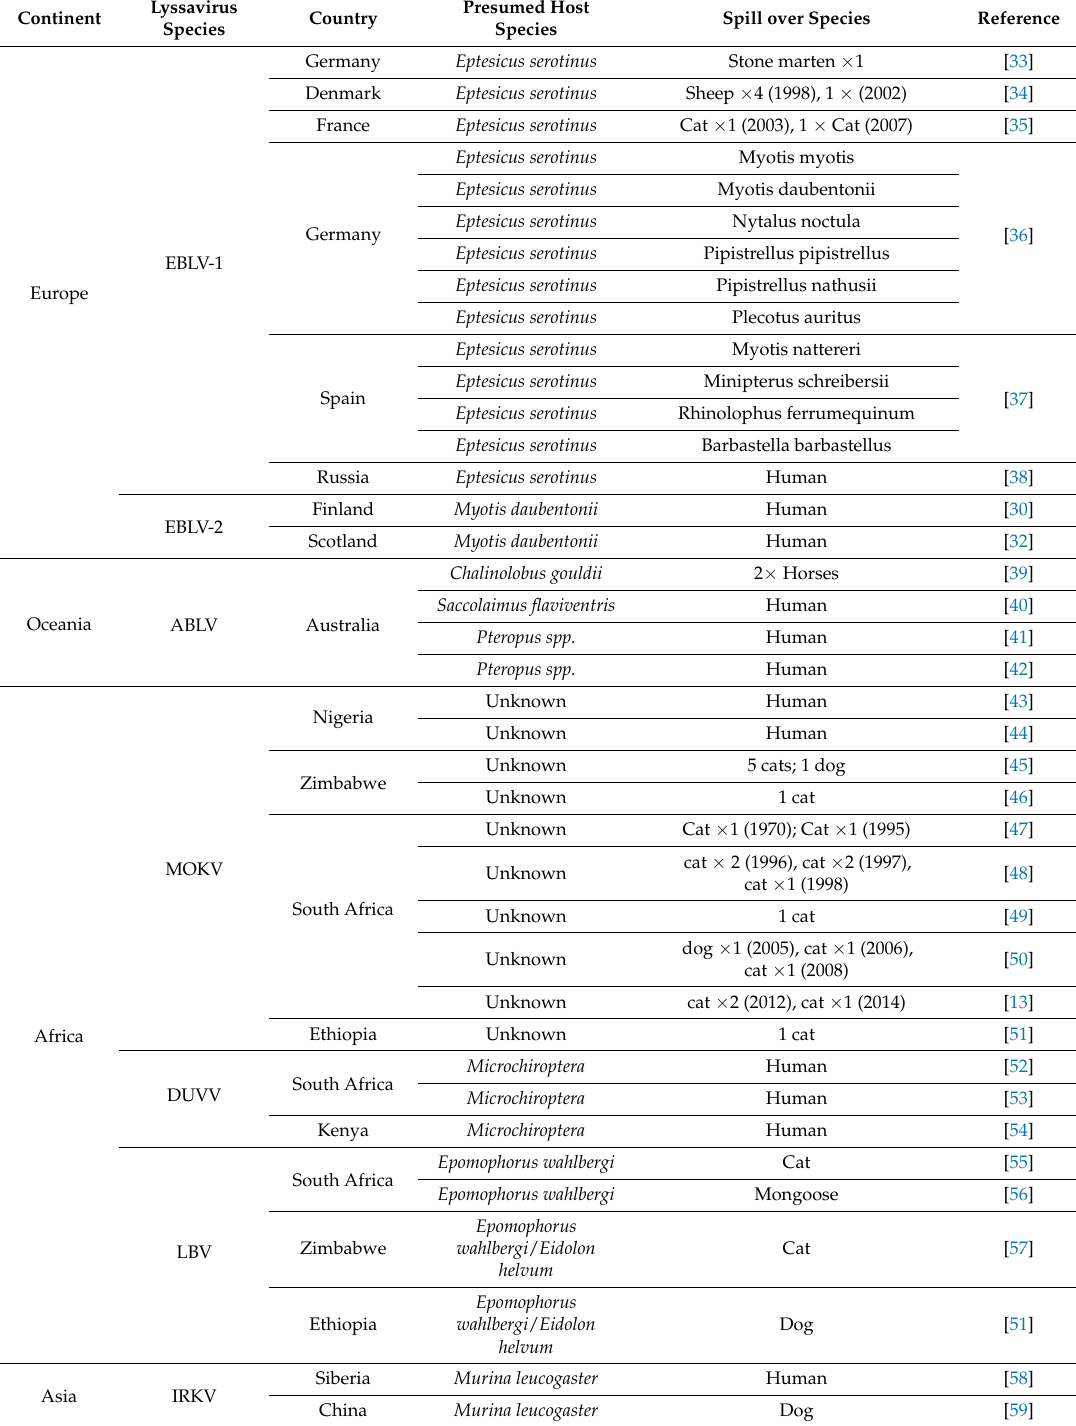
Table 2. Documented lyssavirus spill over